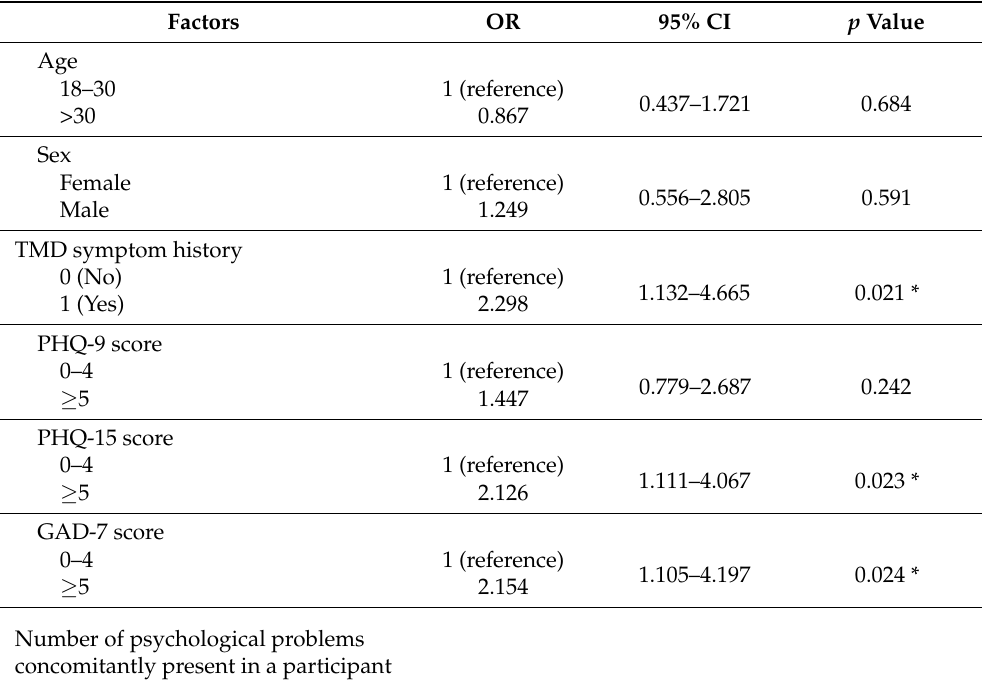
Table 5. Univariate logistic regression analysis of potential risk factors for condylar bony